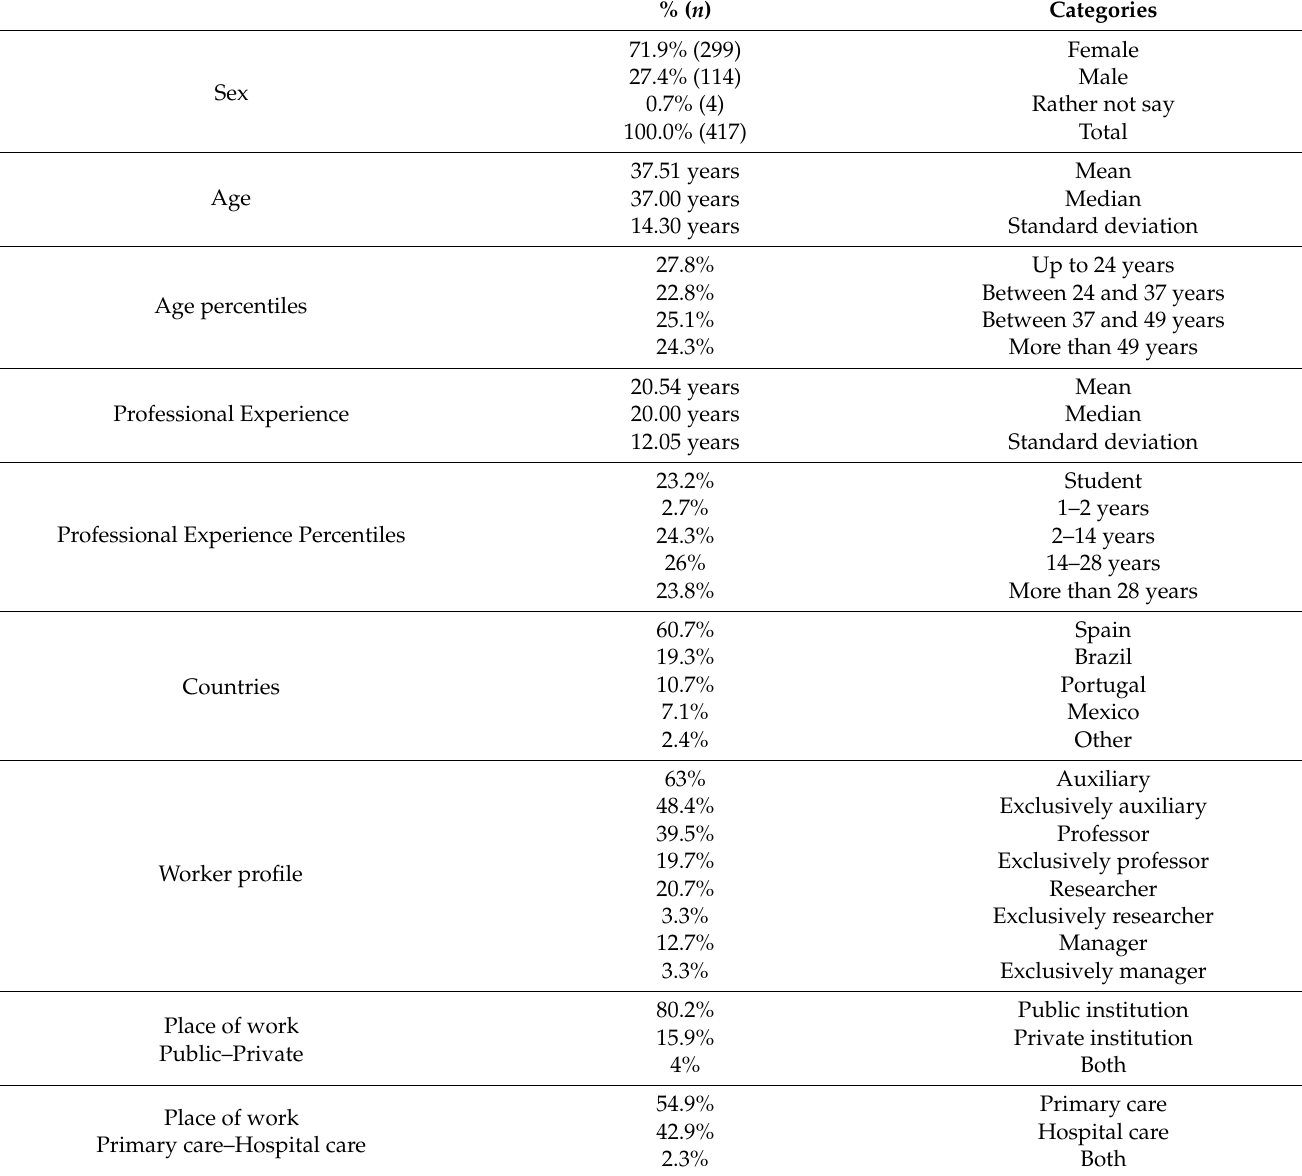
Table 1. Characteristics of the sample responding to the 1Q_LcEE-CAPC